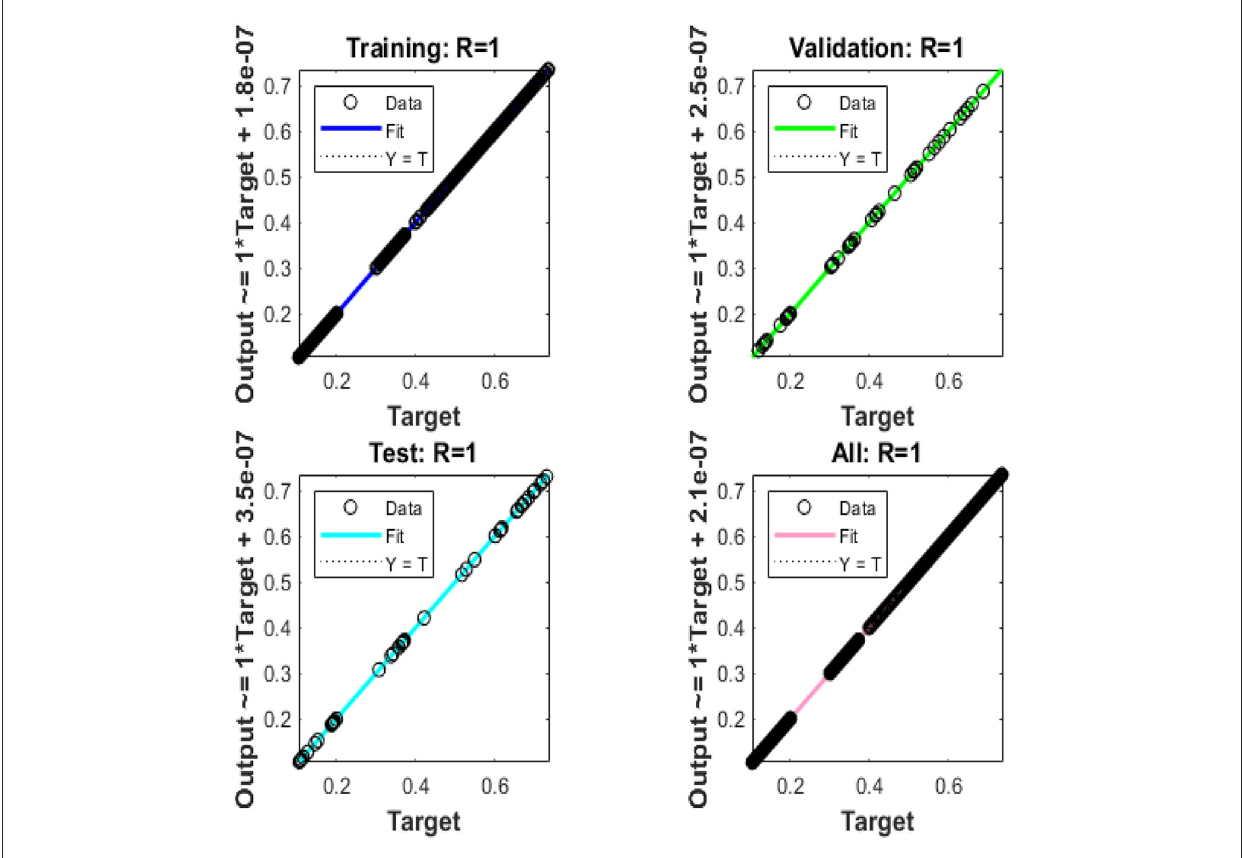
FIGURE7 Regression performances for the HBVNS model: Case 2.